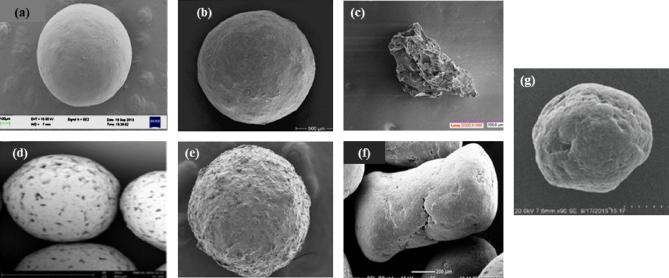
(a) Morphological differences exhibited by Ethocel™ based (a) ofloxacin-loaded floating bioadhesive multiparticulate delivery system (adapted from Zhang et al., 2016a, Zhang et al., 2016b), (b) multi-layered pellets (adapted from Muschert et al., 2009), (c) tacrolimus containing extended release granules (adapted from Tsunashima et al., 2016), (d) rough surfaced pellets (adapted from Priese et al., 2015), (e) osmotic theophylline pellets (adapted from Kazlauske et al., 2017), (f) reservoir type extended release multiparticulates (adapted from Franc et al., 2016), (g) wax based floating sustained-release dispersion pellets (adapted from Yan et al., 2016).